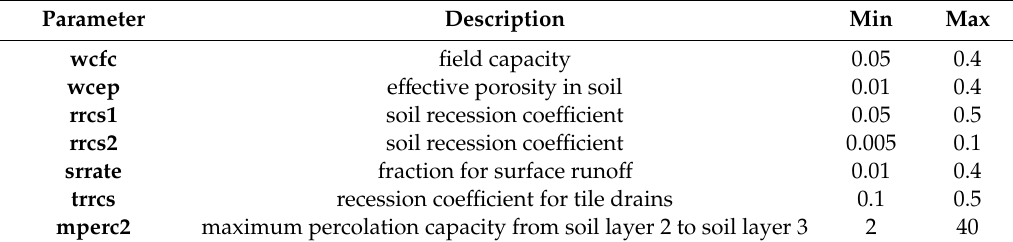
Table 1. Sensitive flow calibration parameters and ranges.